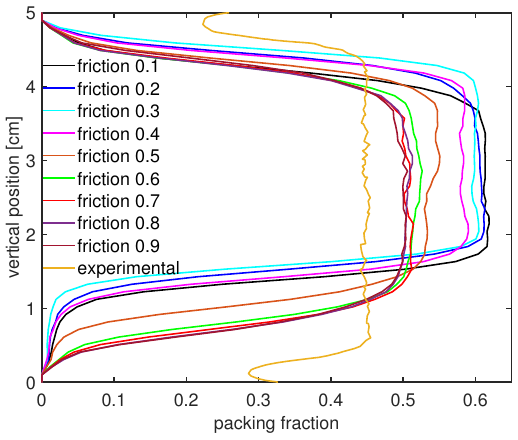
Figure 5. Numerical simulation using a frequency of 25 Hz and amplitude of 1 mm. Coe ffi cient of friction was varied from 0.1 to 0.9. Corresponding experimental result is also shown in the